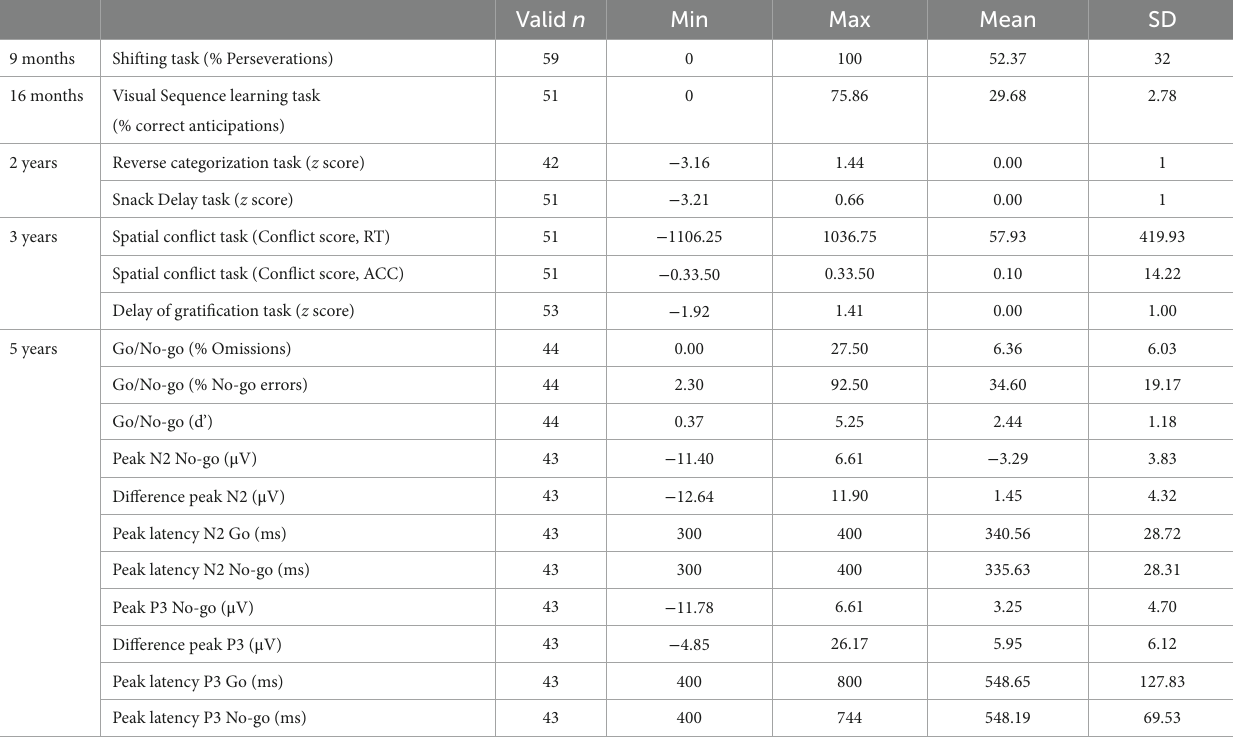
TABLE 1 Descriptive data for all measured variables at the different waves of the